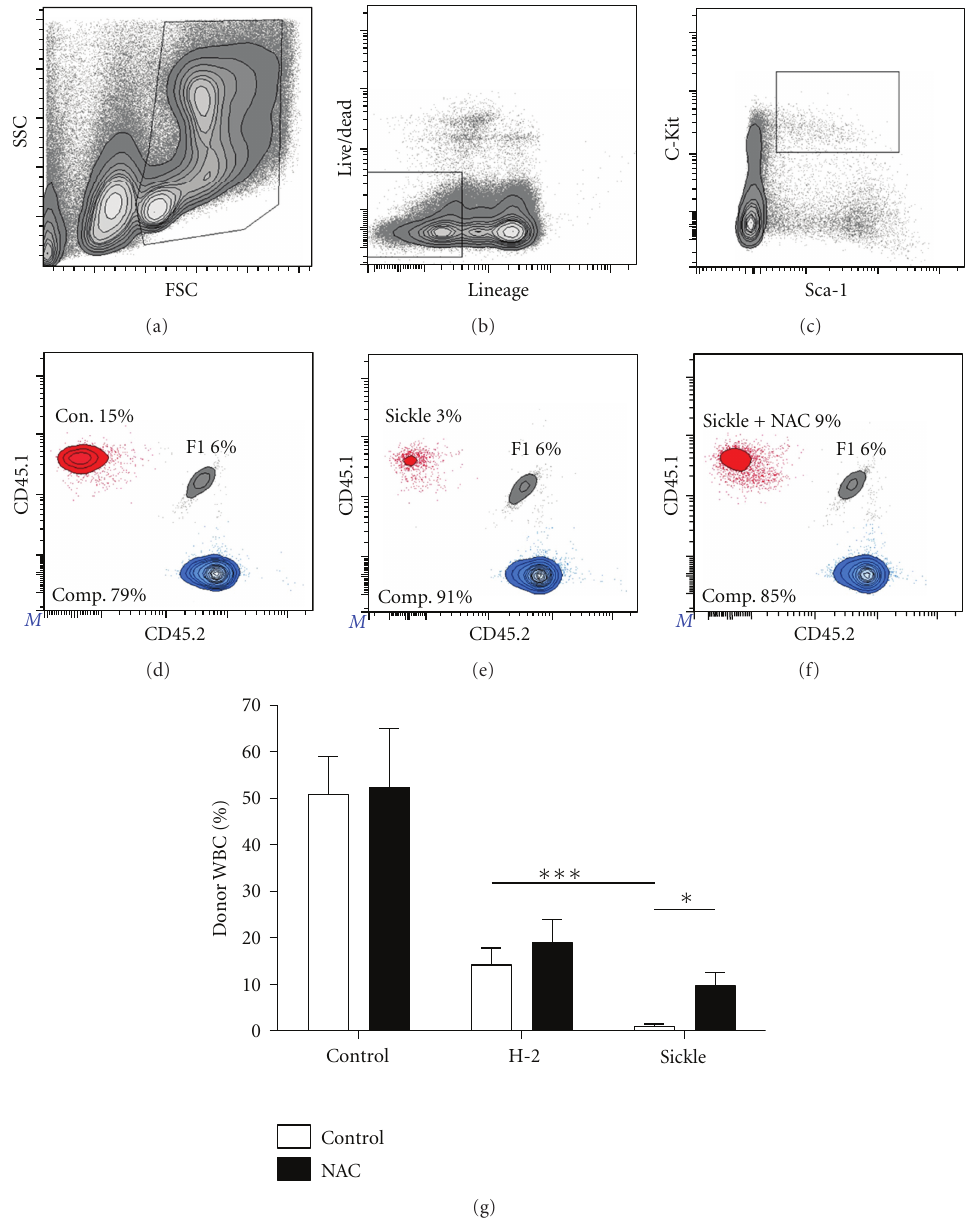
Figure 4: Functional defect of sickle hematopoietic stem cells in a competitive repopulation assay. Strategy for sorting KSL cells from whole bone marrow: mononuclear cells gated on FSC and SSC of whole BM (a), gated lineage and propidium iodide negative on mononuclear cells (b), and c-kit+, Sca1+, Lin − (KSL) cells (c). Peripheral blood engraftment after transplantation. Representative flow cytometry plots showing KSL cells from control mice engrafted at 15% (d), sickle KSL cells engrafted at 3% (e), and NAC- treated sickle KSL cells engrafted at 9% (f). Composite data showing a reduced capacity for engraftment between hemizygous and control mice and a further defect in KSL cells from homozygous mice 24 weeks after transplant (g). Graphical representation of the data from all mice: pretreatment of donor cells with NAC partially restored engraftment of KSL cells from homozygous sickle cell